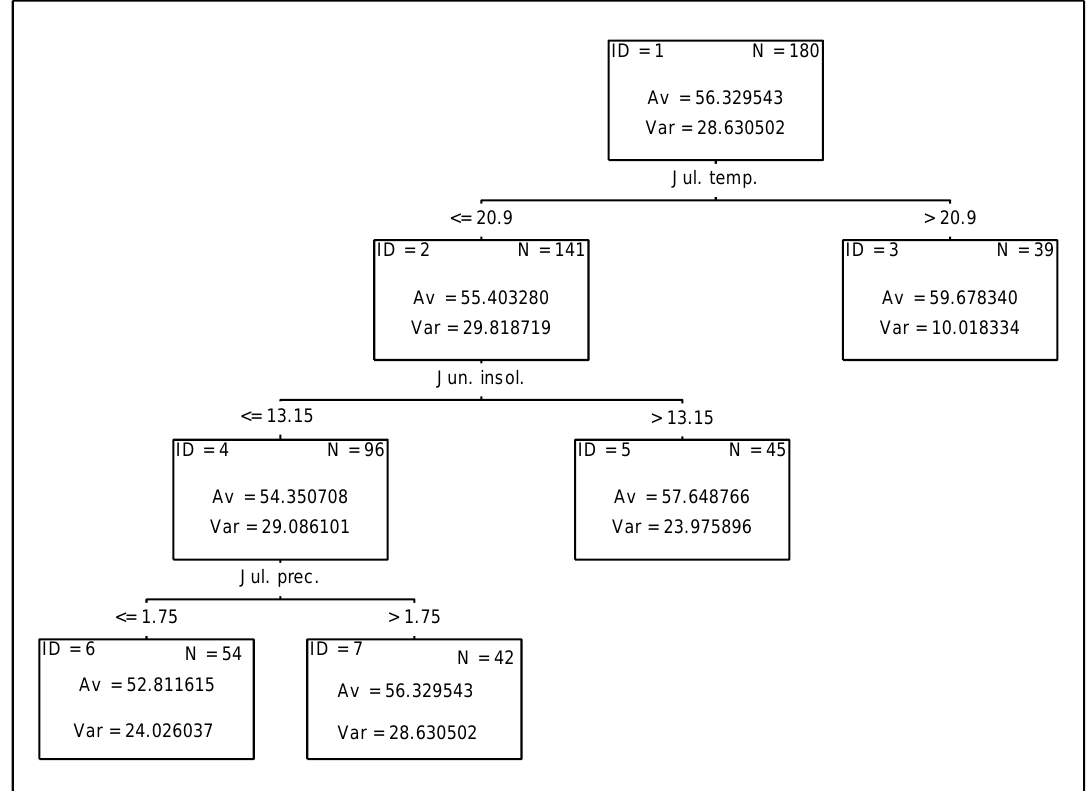
Figure 10. Diagram of regression tree reflecting nitrogen acquisition from soil by control soybean plants.